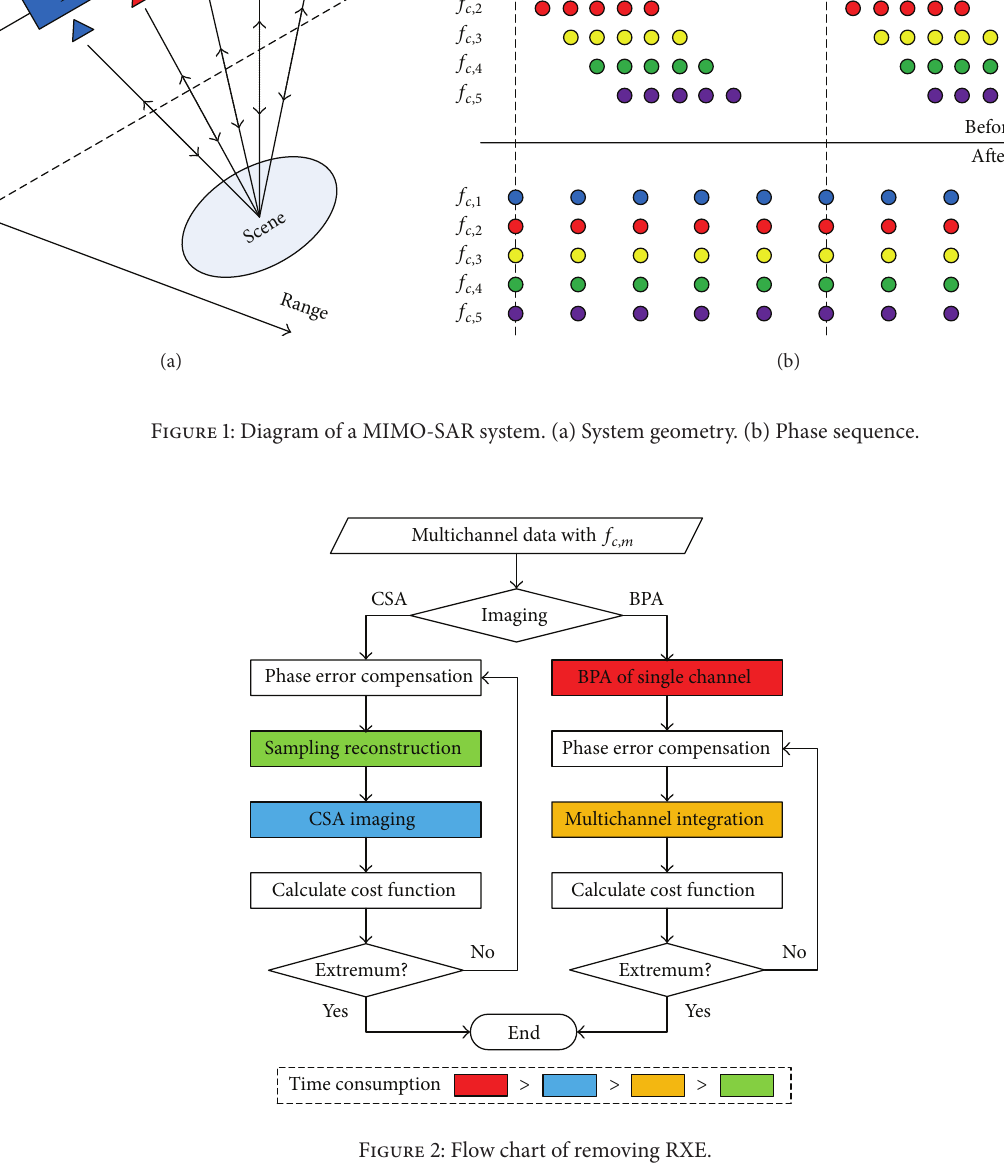
Figure 2: Flow chart of removing